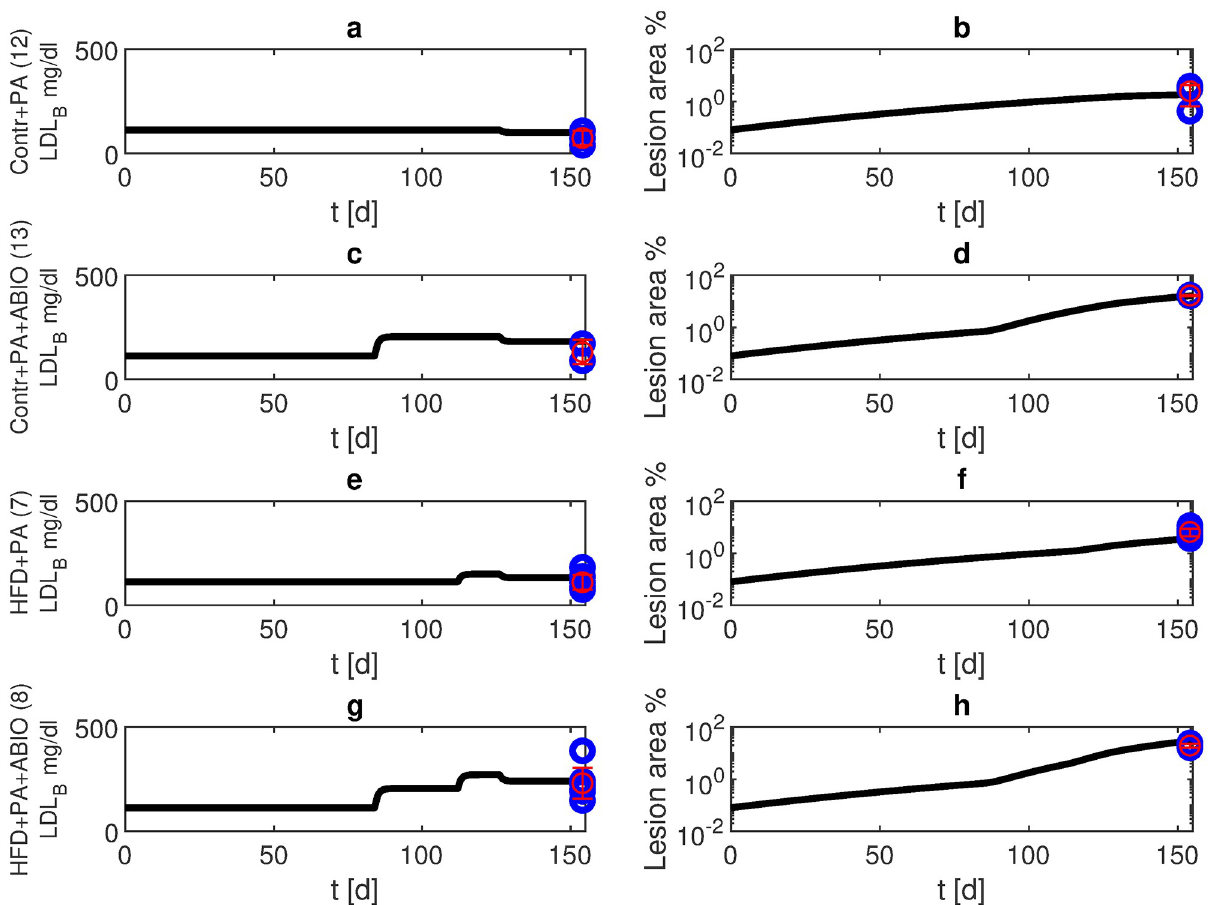
Fig 8. Propionic acid treatment. We present simulation results and data from own experiments of APOE -/- mice receiving propionic acid from the age of 18 weeks until the end of observation period (blue: data points, red: mean and standard deviation for scenarios 12 (normal diet, panels a, b), 13 (antibiotic treatment from week 12, panels c, d), 7 (HFD from week 16, panels e, f), and 8 (antibiotic treatment from week 12 and high fat diet from week 16, panels g, h). Black curves represent model simulations of LDL-C in blood (panels a, c, e, g) and lesion area (panels b, d, f, h).